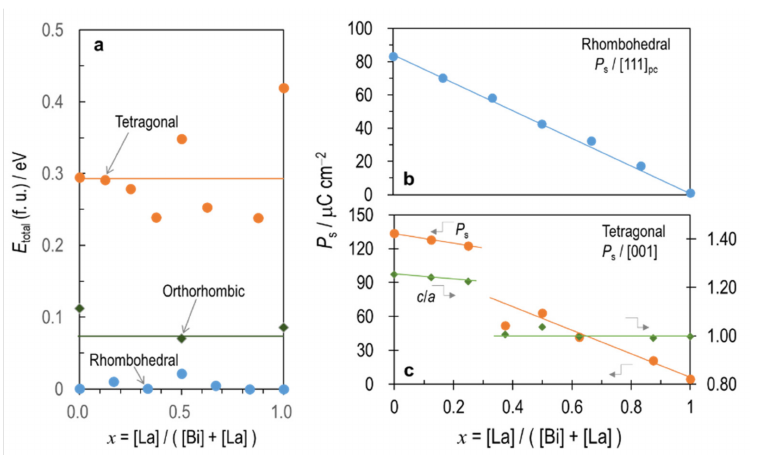
Figure 2. Phase stability and P s : ( a ) total energy ( E total ) of the ABO 3 formula unit (f. u.); ( b ) P s in the rhombohedral system; and ( c ) P s and c / a in the tetragonal system as a function of La content ( x ). For comparing E total in different symmetries, we set the energies obtained by fitting the DFT energies of the rhombohedral cells by a quadratic function to